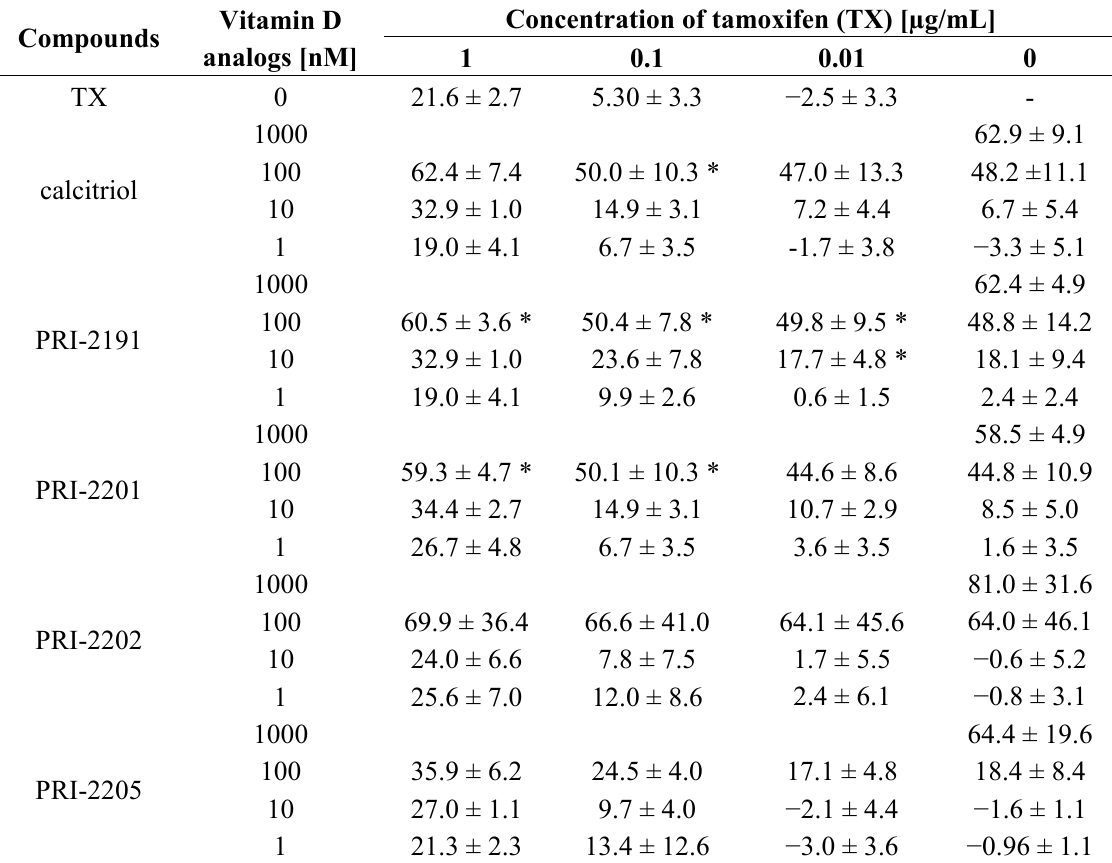
Table 5. The proliferation inhibition of MCF-7 cells exposed to calcitriol or its analogs and tamoxifen.